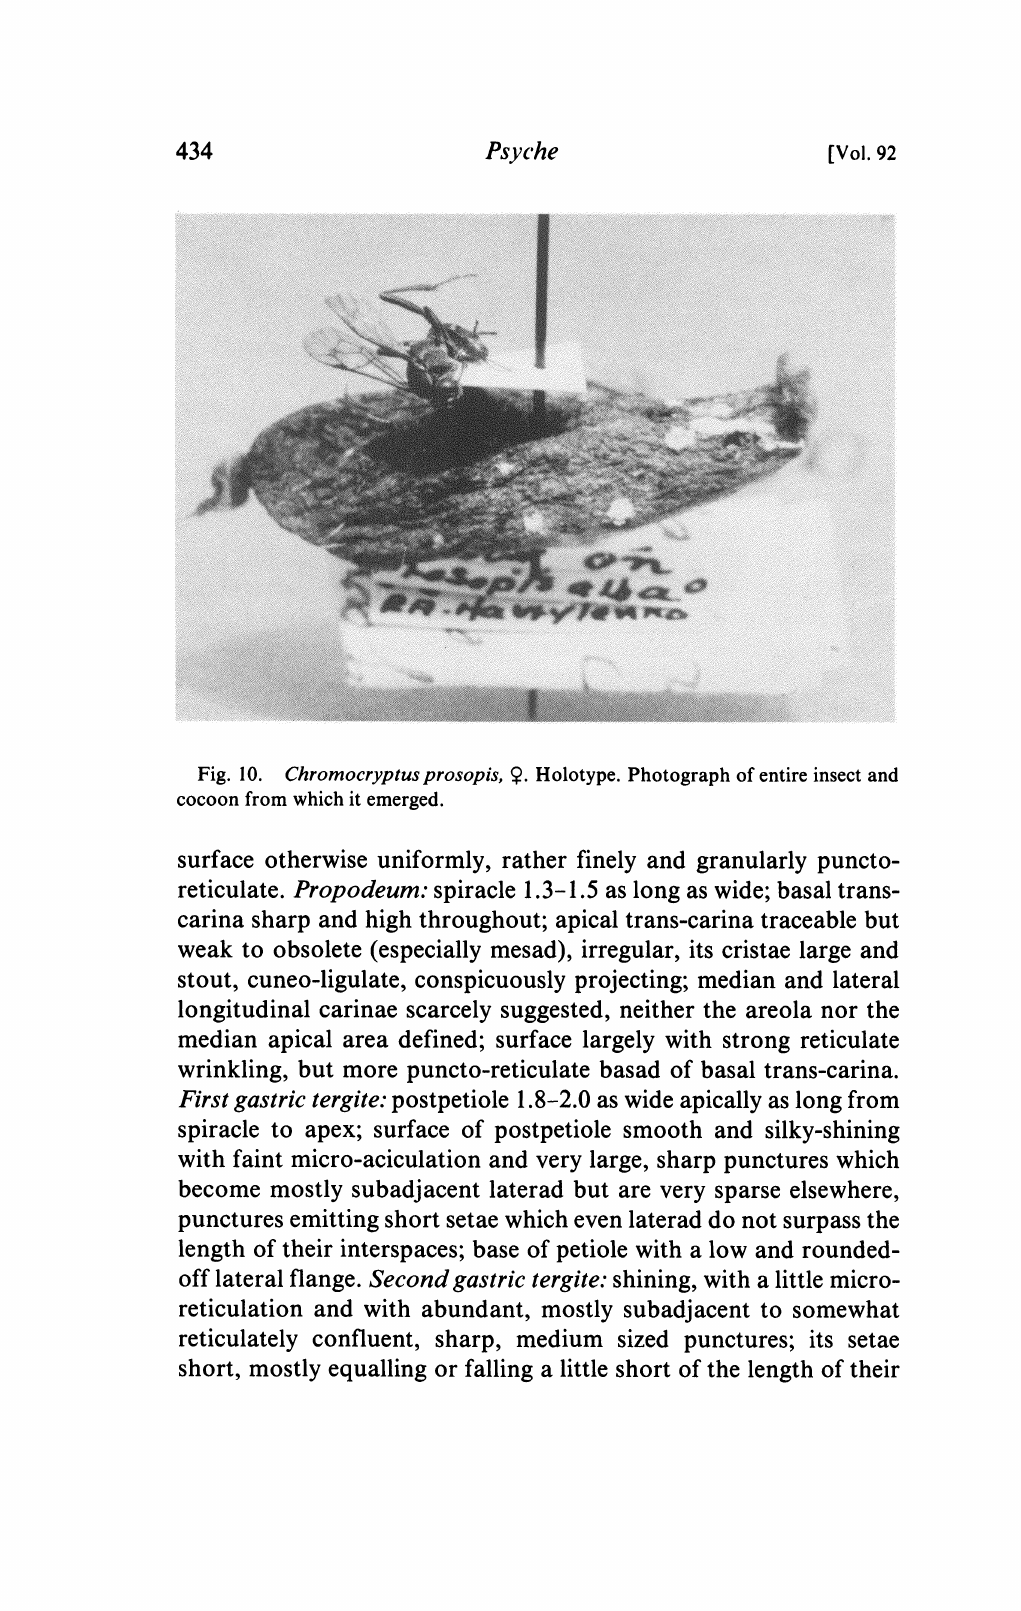
. H olotype. Photograph of entire insect and